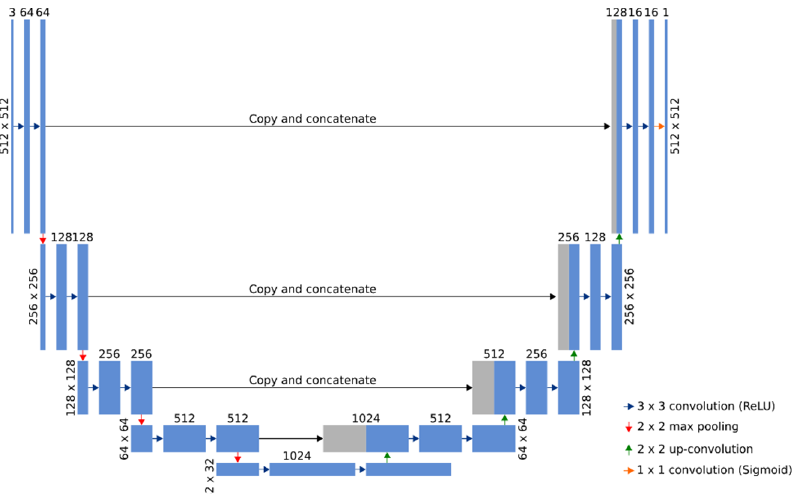
Figure 2. The architecture of a fully convolutional neural network model based on U-Net [57]. Multi- channel feature maps are represented by blue rectangles with dimensions and the number of channels shown on the left and top sides of the rectangle, respectively. The copied feature maps from the contracting path are represented by gray rectangles. The map on the left is the 3-channel patch of the experimental OM image and the map on the right is the binary mask prediction.